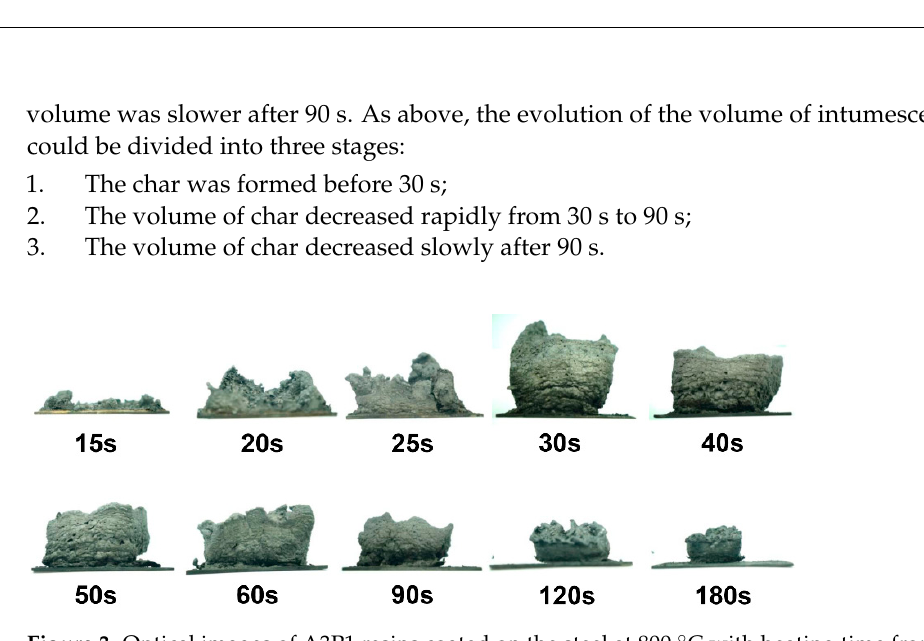
Figure 3. Optical images of A3P1 resins coated on the steel at 800 °C with heating time from 15 s to 180 s.